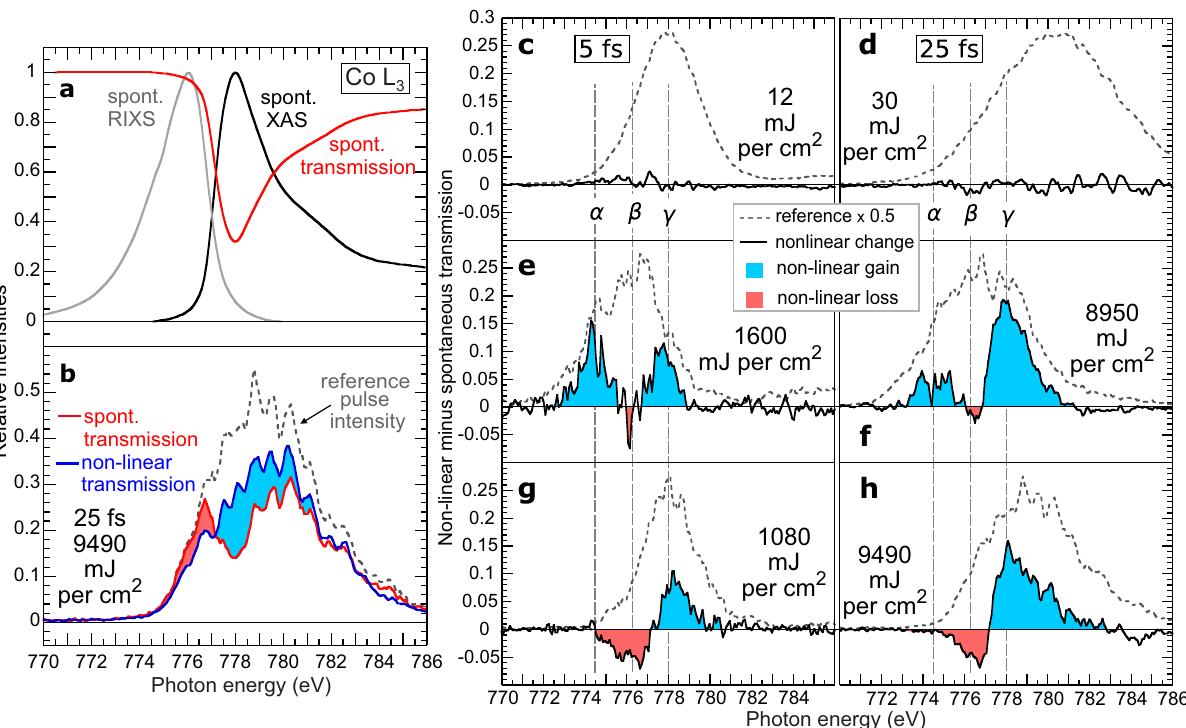
Fig. 2 Summary of experimental results. a Comparison of the scaled spontaneous Co L 3 Resonant Inelastic X-ray Scattering spectrum (RIXS, gray) for Co metal 33 and the Co/Pd X-Ray Absorption Spectrum (XAS, black), both recorded at synchrotron light sources (low fl uence limit). The red spectrum is the transmission version of the XAS spectrum. b Example of data extraction and normalization. The dashed gray line is the reference spectrum of a 25 fs pulse of 9490 mJ per cm 2 fl uence transmitted through the SiN window, multiplied by 0.55 to account for the constant non-resonant absorption of the Co/Pd sample. The blue curve is the measured transmission spectrum through the Co/Pd sample at the stated high fl uence. The red curve is the spontaneous (low fl uence) transmission spectrum, obtained by multiplying the red spectrum in ( a ) by the dashed-gray reference spectrum. Light blue shaded areas indicate non-linear gain and red areas non-linear loss. ( c – h ) show as dashed lines the reference spectra transmitted through the SiN for 5 fs and 25 fs pulses for different pulse shapes and fl uences. The associated transmission difference spectra are shown as solid black lines. They were obtained by subtraction of the spontaneous low- fl uence spectra from the non-linear high- fl uence spectra for the respective transmission curves. The shading of areas corresponds to the procedure (blue minus red curves) illustrated in ( b ). Each spectrum is an average of many shots. The centers of three regions with non- linear response are denoted by dashed vertical lines and labeled α , β and γ